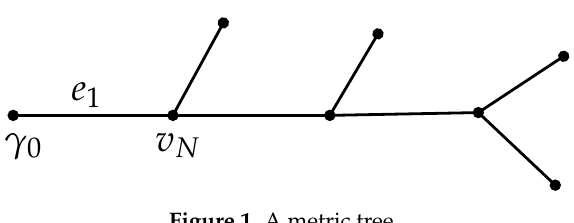
Figure 1. A metric tree.